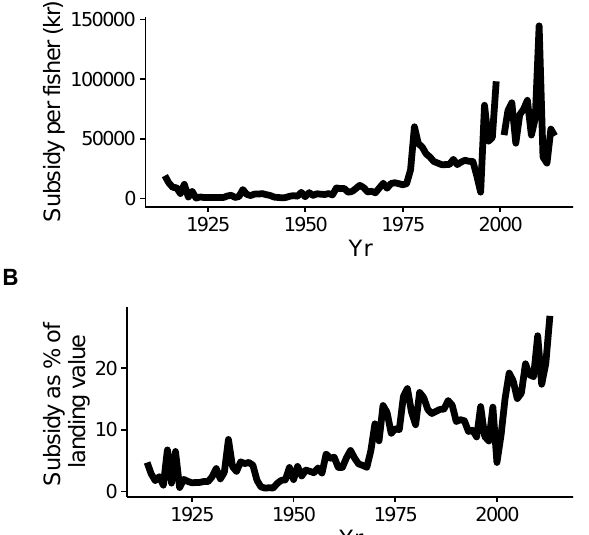
Fig A1.2. Time series of subsidy levels (all three categories): (A) per fisher, and (B) per total gross landing value. Note that both subsidy per fisher and subsidy in relation to landing value has increased strongly over